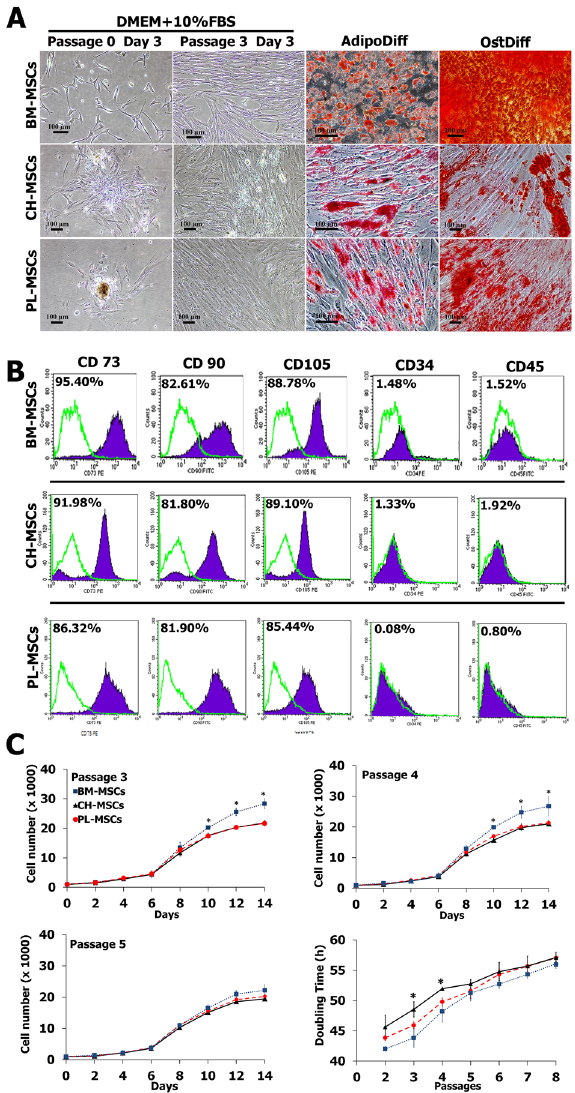
Figure 1. The characteristics of MSCs isolated from human chorion (CH-MSCs) and placenta (PL-MSCs) in comparison with MSCs isolated from human bone marrow (BM-MSCs). ( A ) The fibroblast-liked morphology and differentiation potential of CH-MSCs, PL-MSCs, and BM-MSCs. ( B ) Flow cytometry demonstrated the expression of typical MSC markers in CH-MSCs and PL-MSCs compared to BM-MSCs. ( C ) Growth characteristics of CH-MSCs and PL-MSCs compared to BM-MSCs. Data are presented as mean±standard error of the means (SEM). Scale bar = 100